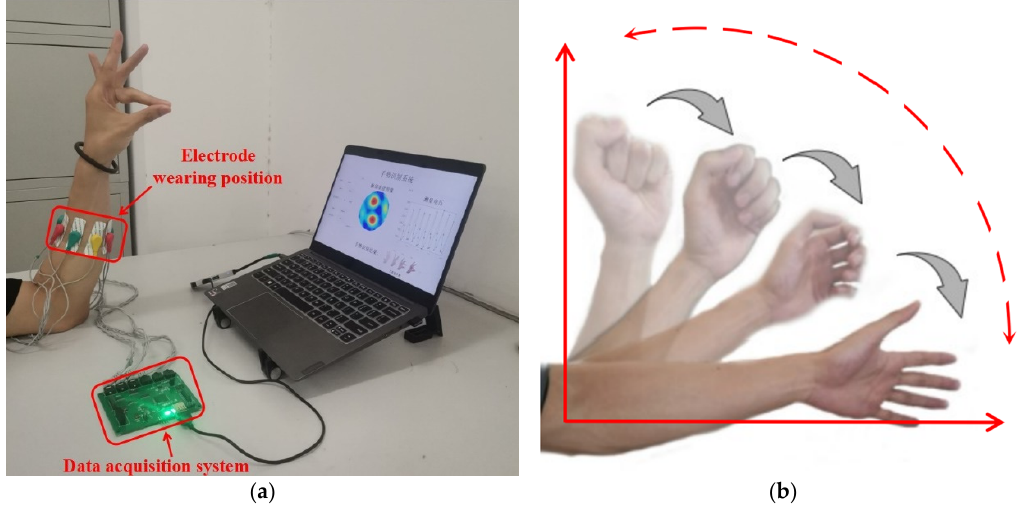
Figure 6. ( a ) Data acquisition experimental setup. ( b ) The shaking arm interference experiment.